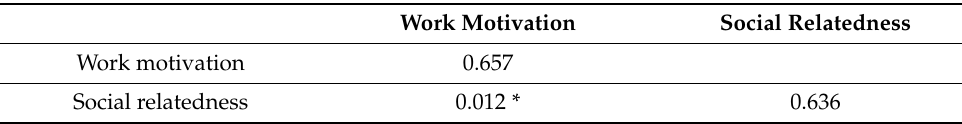
Table 4. Discriminant validity—Fornell and Larcker’s